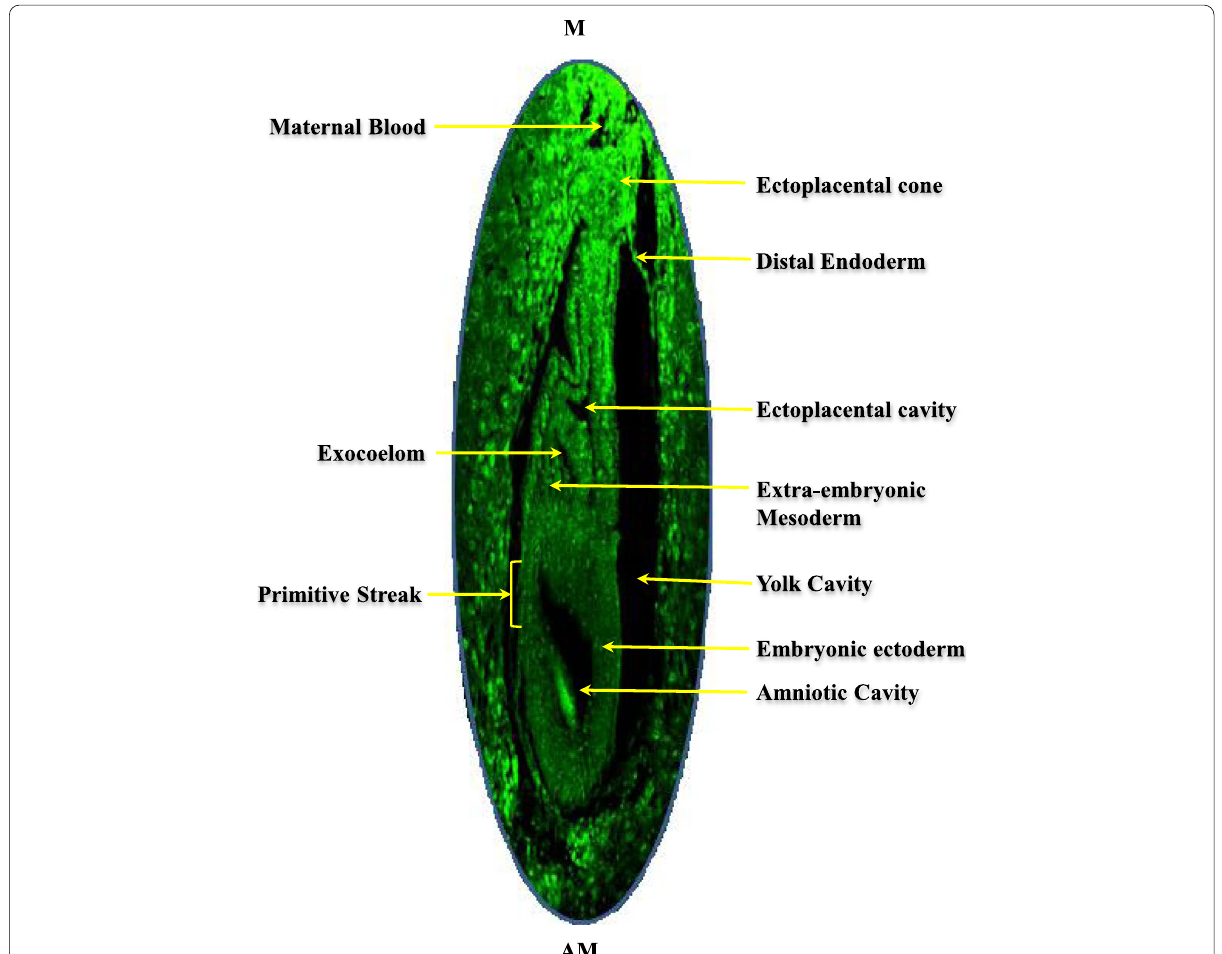
Fig. 6 Structure of D7 mice embryo and expression of KLF5 in different cell types. The transcription factor was localized in various embryonic and extra-embryonic cells. M, mesometrial pole; AM, antimesometrial